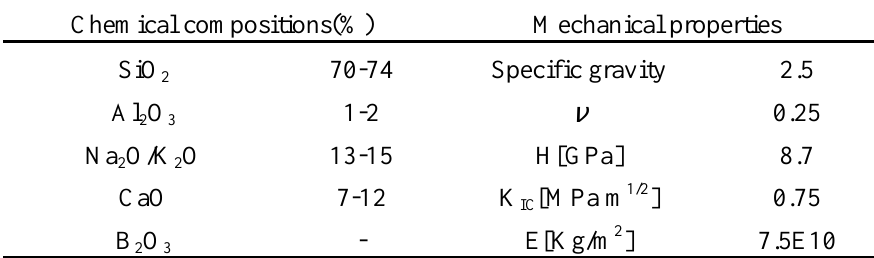
Table 2. Properties of the soda lime